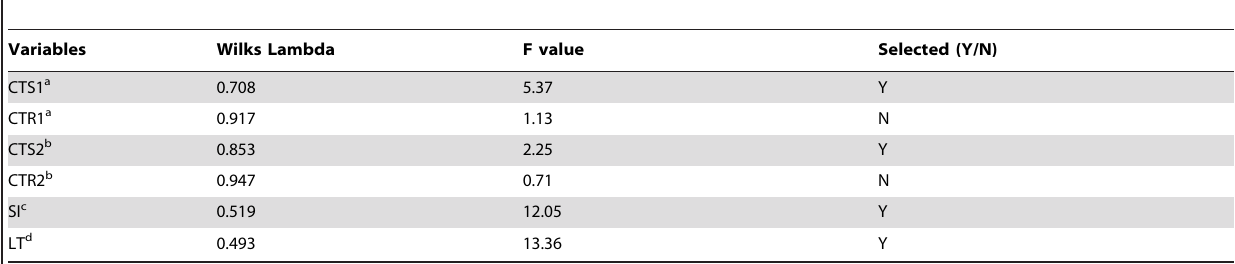
Table 4. Selected variables of antibacterial activity by stepwise discriminant analysis at Chi =76.4 and P =